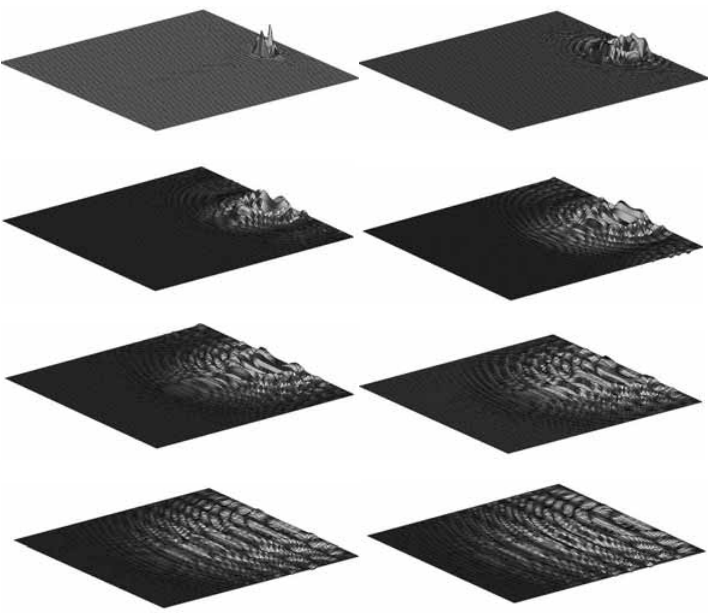
Fig. 8. Wave propagation at 10, 60, 110, 160, 210, 260, 310, 360 micro-sec due to edge actuation by a PZT